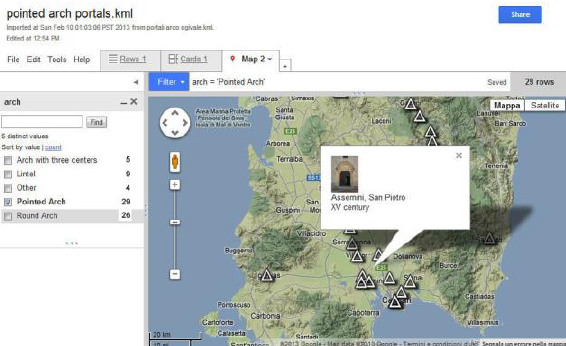
Figure 5. Screenshot of the map created by Google Fusion Tables.